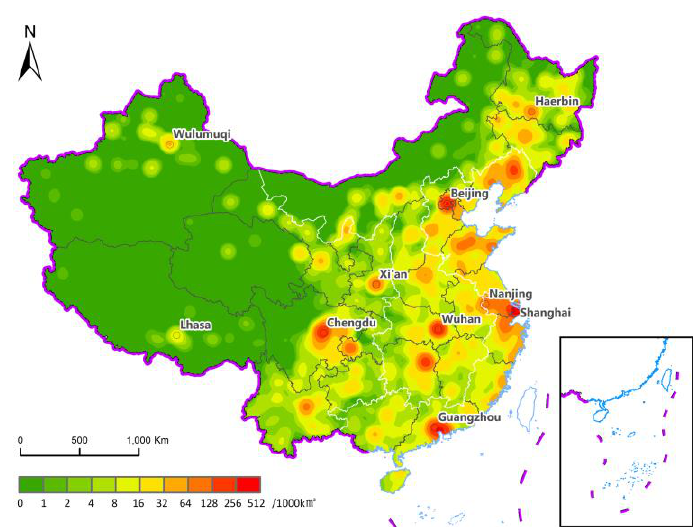
Figure 1. The spatial distribution of karaoke bars in China (Source: [6]).